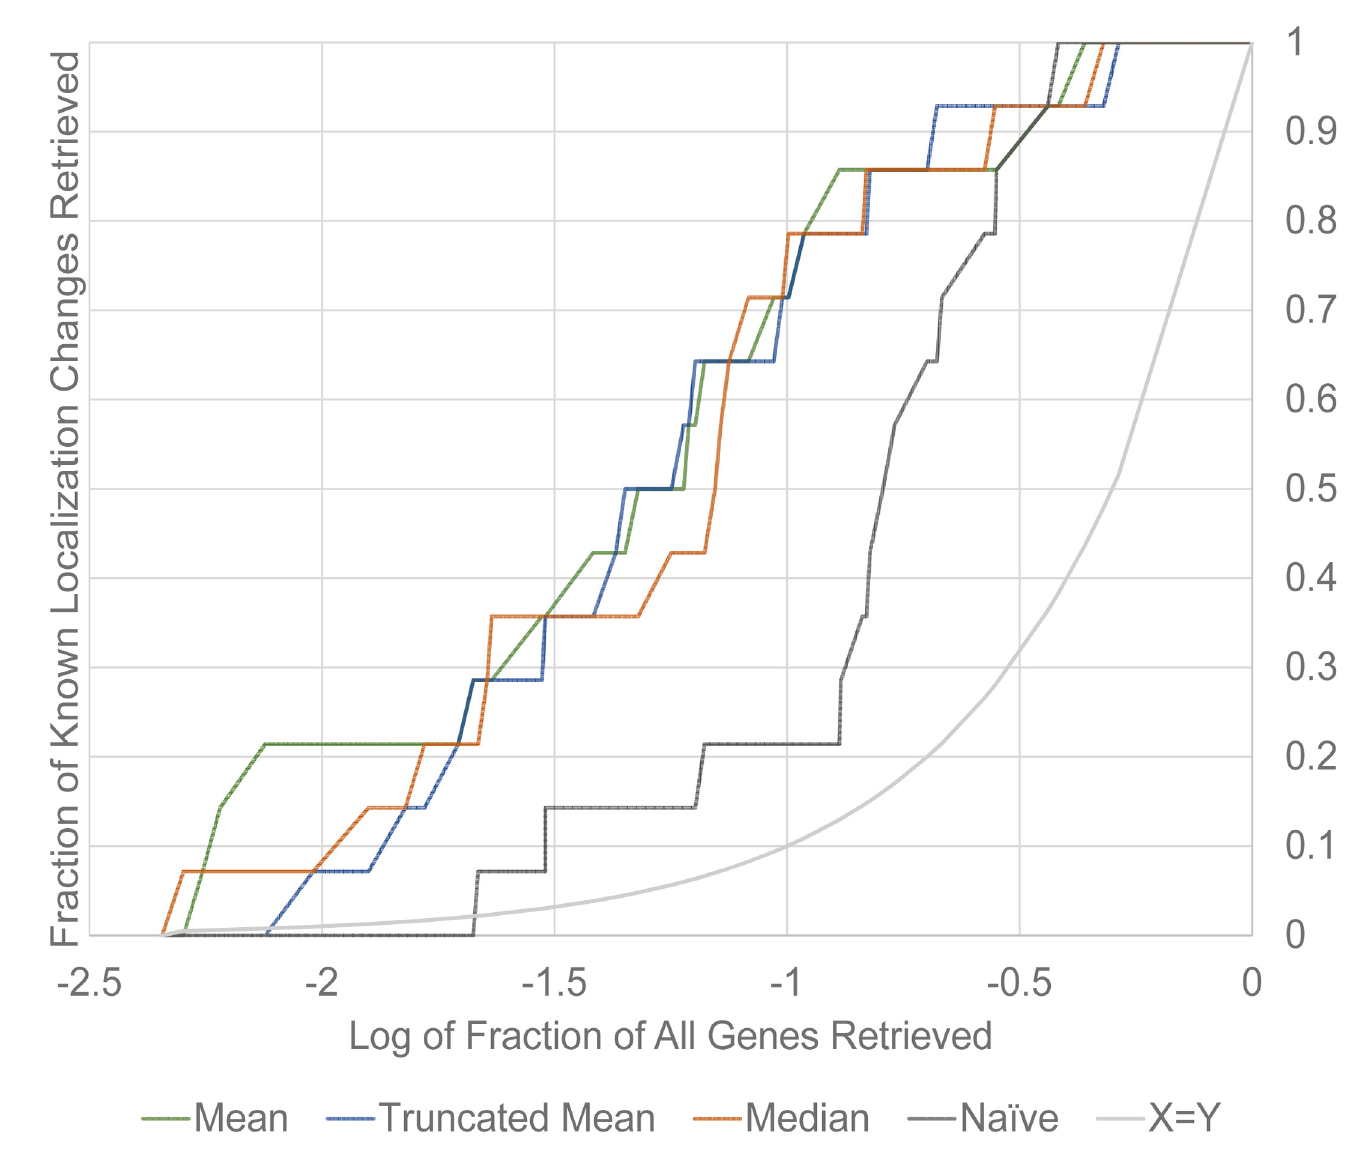
Fig 2. Fraction of known localization changes retrieved against the log 10 of fraction of all genes retrieved for the k NN method with mean, truncated mean and median profiling. We also show the na ï ve method and the X = Y curve for